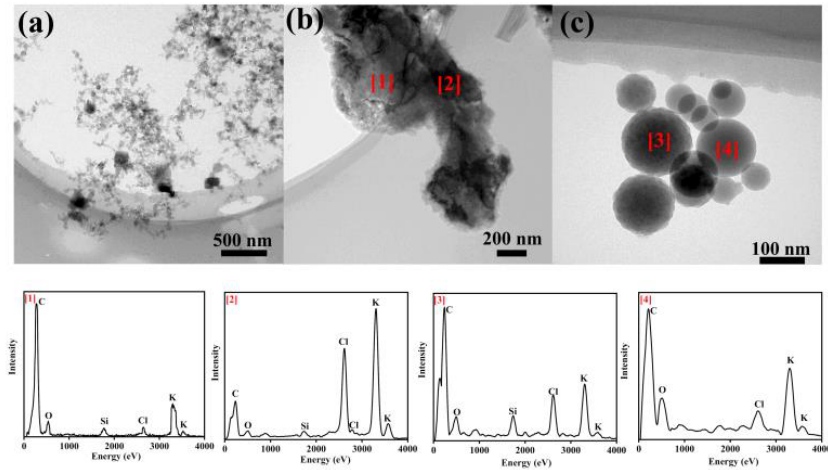
Figure 8. TEM images and EDS spectra of PM from the combustion of wheat straw. ( a ) TEM images of multi-particle network morphology, ( b ) TEM images of soot morphology, ( c ) TEM images of individual particles. The corresponding EDS spectra are indicated by the number in square brackets.